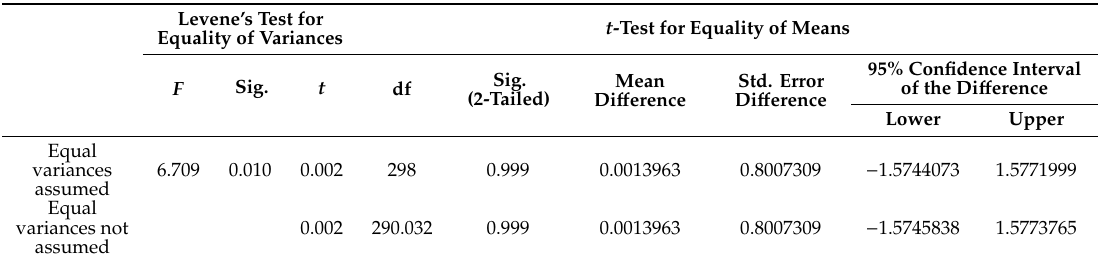
Table 9. T-Student test for Taste Index property based on PLSR Method.